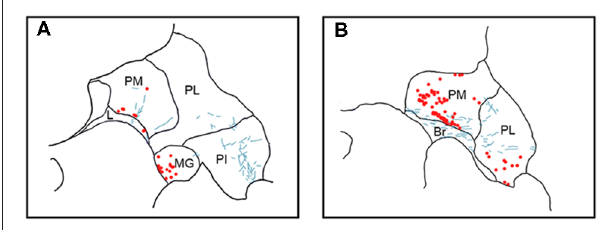
FIGURE 5 | Pattern of overlapping label in Case S1. Each panel (A,B) presents a plot of labeled cell bodies or fibers from different rostro-caudal levels through the pulvinar. Anterograde label (putative axons) after injection of FE in the SC are shown in cyan. Retrograde label (cell bodies) after injection of CTB in the amygdala are shown in red. Abbreviations for thalamic nuclei are as in Figure 1 . Br, brachium of the superior